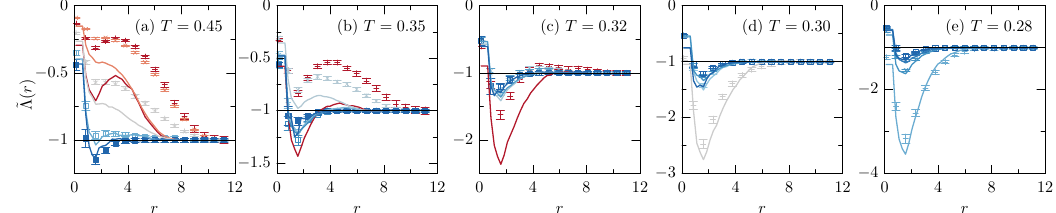
Figure 15: Finite size effects on the energy profile for saddles. All parameters are the same as in Fig.